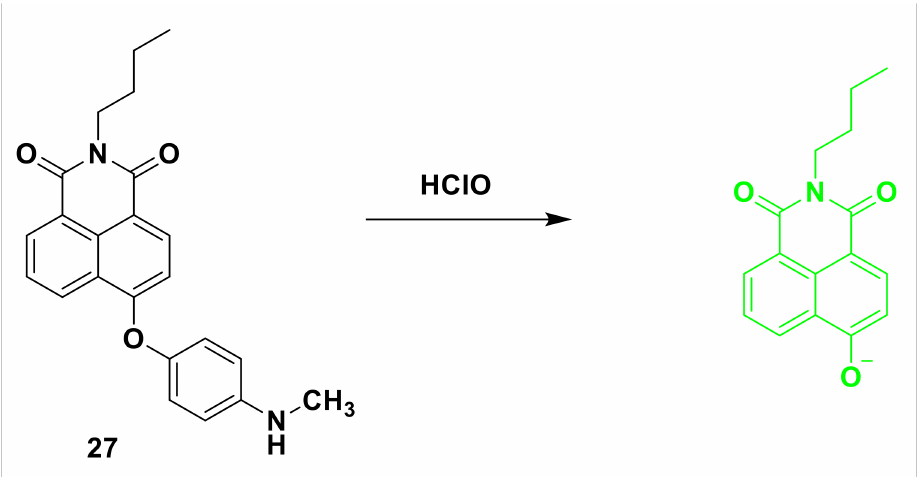
Figure 27. The reaction of probe 27 and